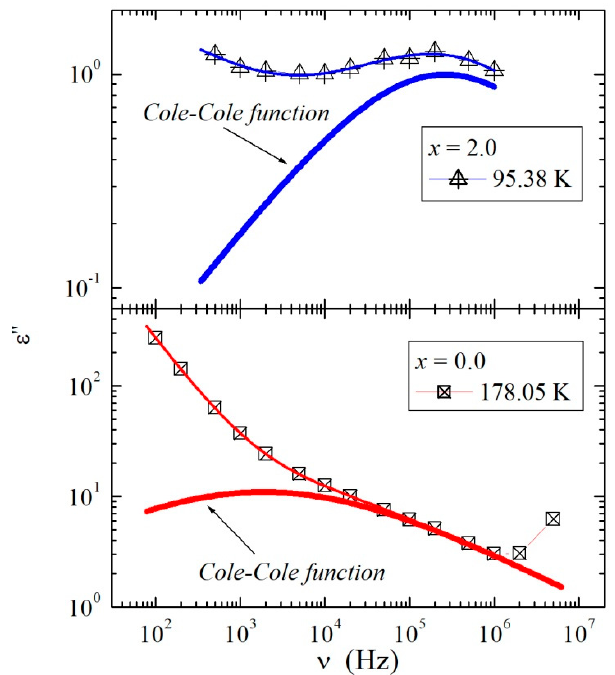
Figure 11. ε ’’(v) spectra with fitting function for samples with x = 2.0 (upper panel) and 0.0 (lower panel).